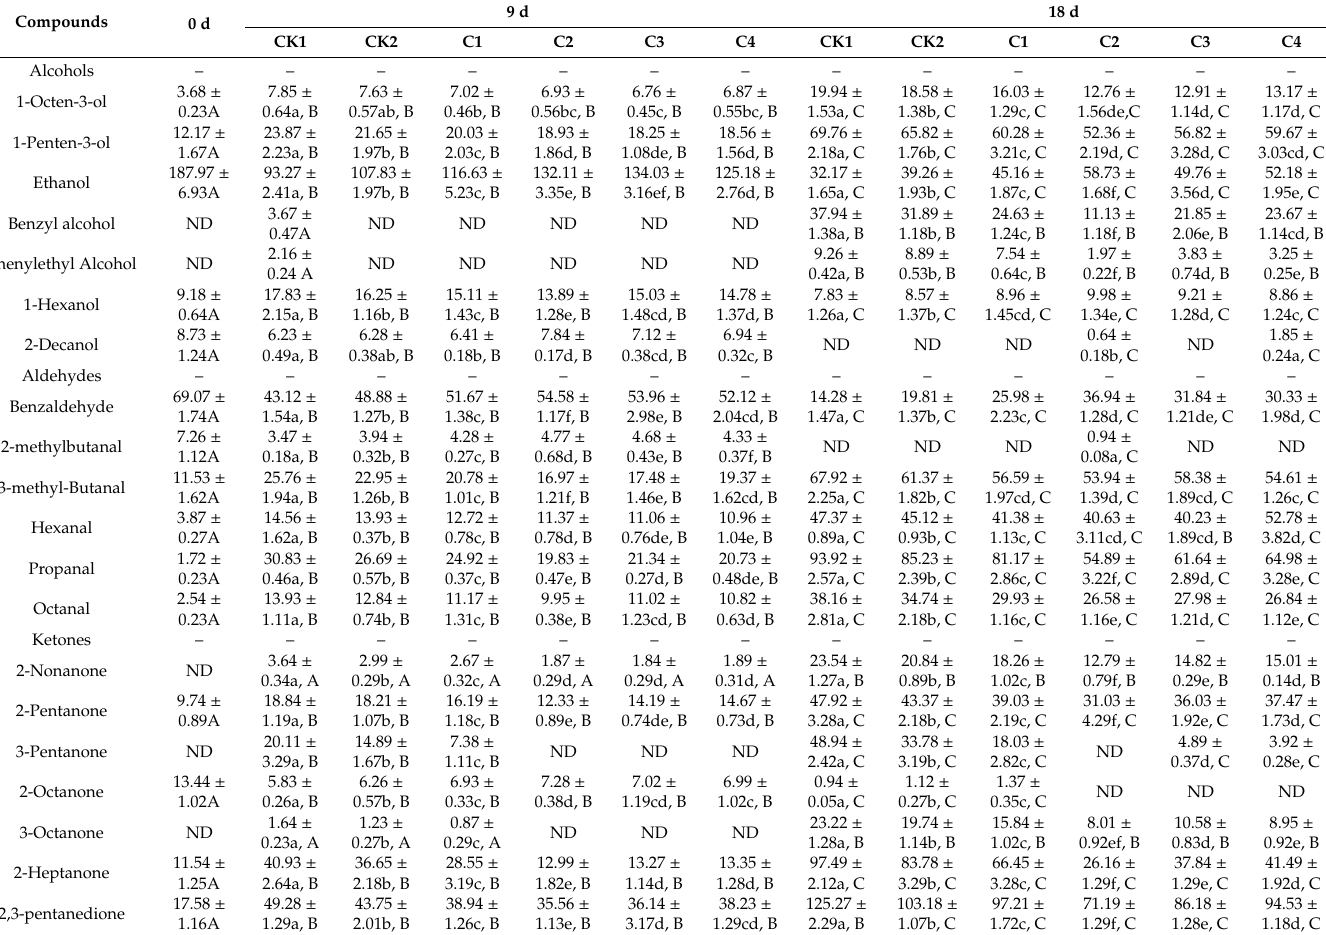
Table 3. Identification and semiquantification of main volatile compounds ( µ g / kg) identified in half-smooth tongue sole (HTS) fillets after 0, 9, and 18 days of cold